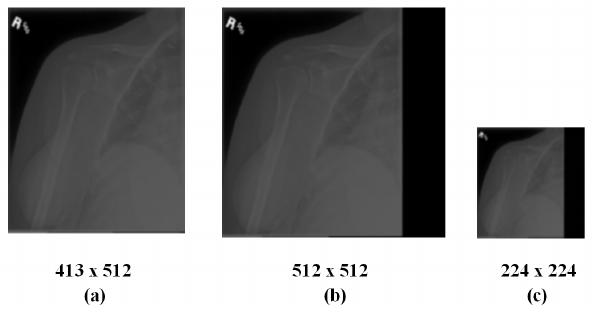
Figure 1. Preprocessing of images ( a ) Original image, ( b ) Padded image, and ( c ) Resized